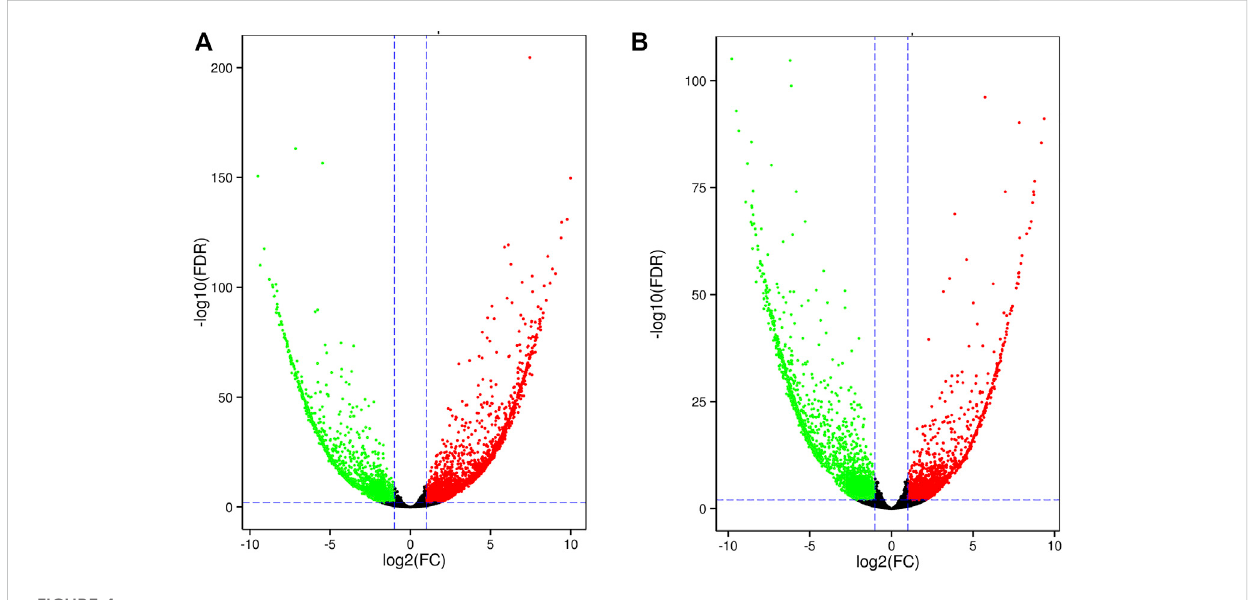
FIGURE 4 Volcano plot of DEGs in leaf tissue at 6 h (A) and 24 h (B)